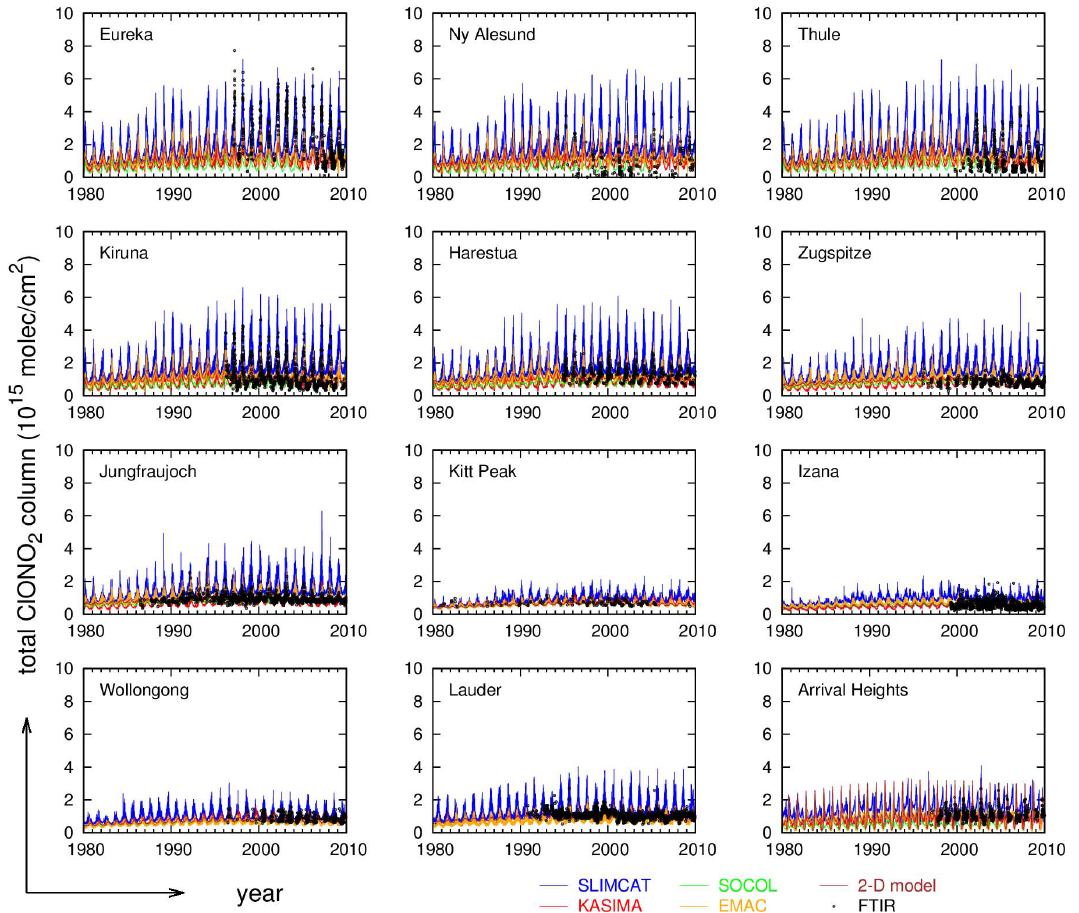
Fig. 4. Time series of ClONO 2 total column abundances in molecules per cm 2 at the different sites as measured by FTIR (black dots) and simulated by SLIMCAT (blue line), KASIMA (red line), SOCOL (green line), EMAC (orange line), and Bremen 2-D model (brown